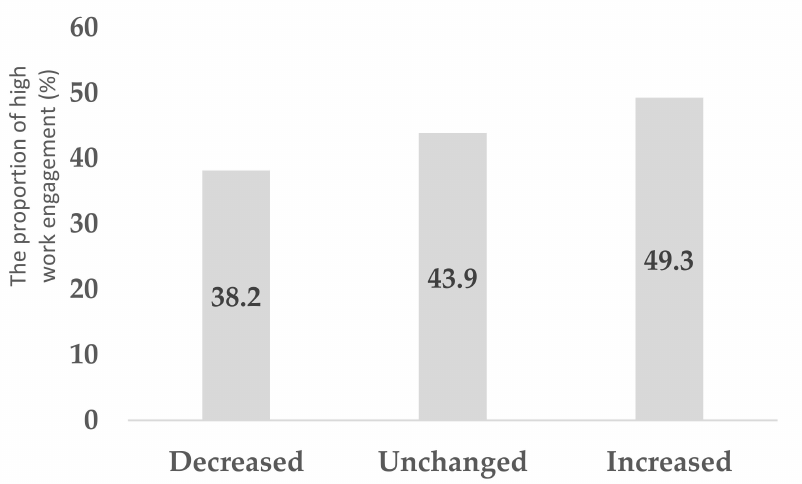
Figure 1. The association between the change in sleeping hours and higher work engagement among employees working from home.